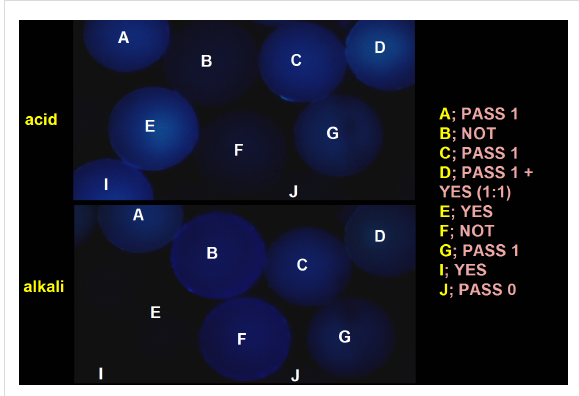
Figure 5: Fluorescence micrographs (excited at 366 nm) of 0.1 mm polymer beads carrying MCID tags. The beads are treated with (a) acid and (b) alkali in aqueous methanol (1:1, v/v). The logic gate type of each bead is given in the legend. Photograph adapted from [67], Copyright (2006) Macmillan Publishers